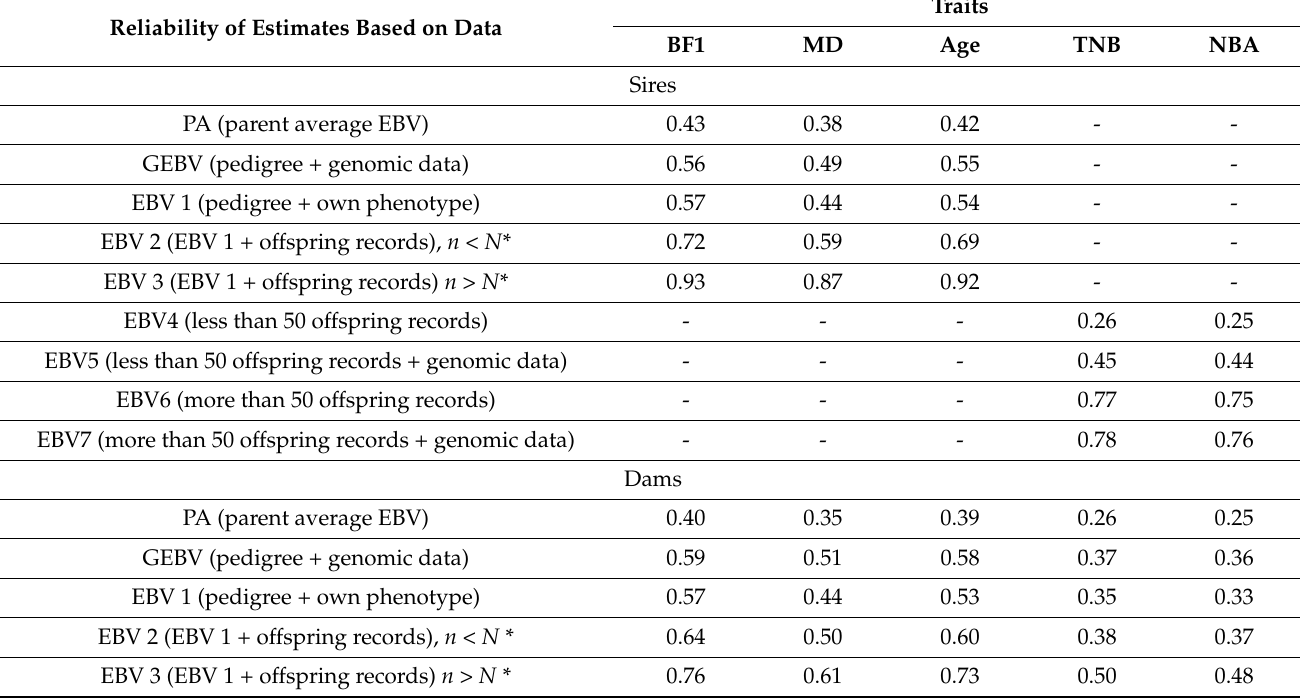
Table 6. Reliability of predicted EBV/GEBV depending on the type of data included in the calculation *. Reliability of Estimates Based on Data